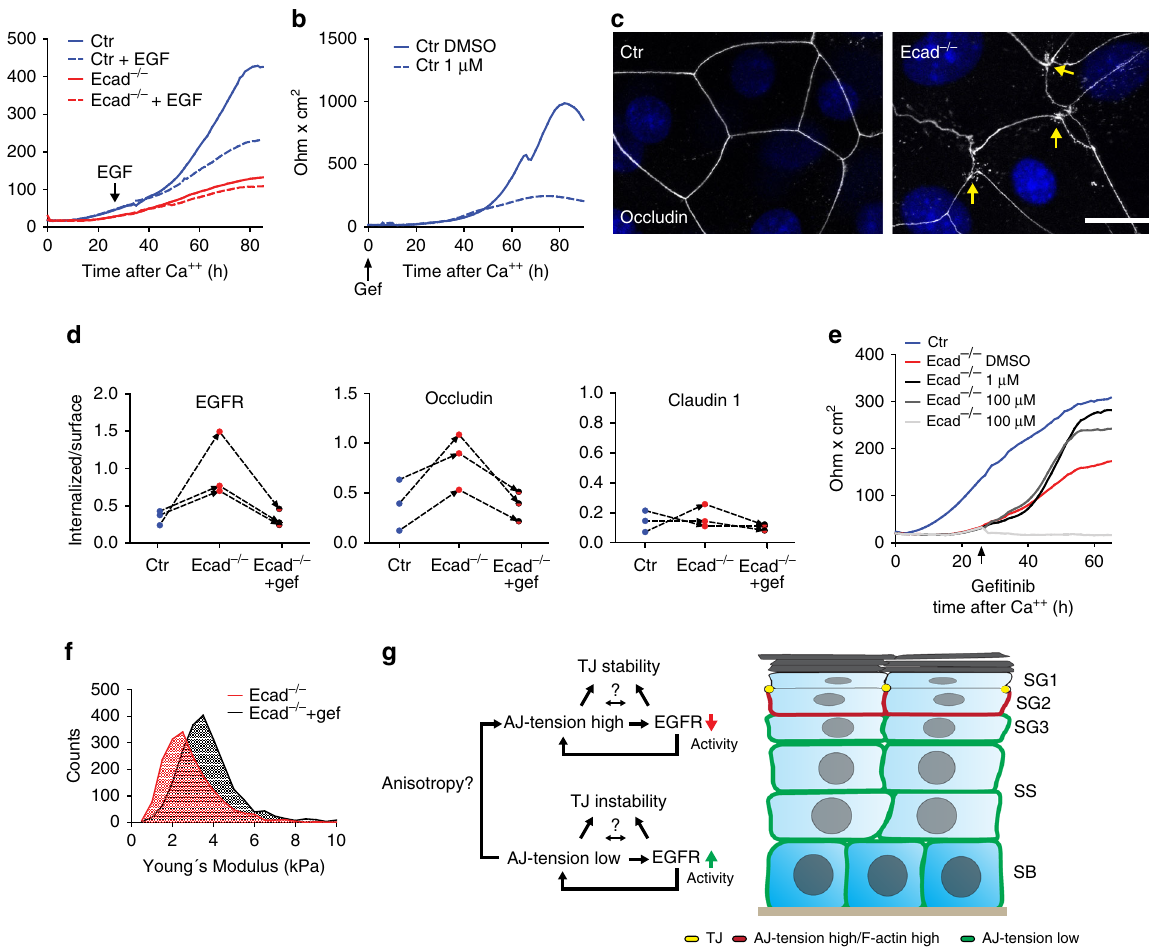
Fig. 8 Spatiotemporal control of EGFR localization and activity controls TJ barrier function. a , b Transepithelial resistance (TER) measurements in primary keratinocytes. a Control (Ctr) keratinocytes were stimulated with EGF (100 ng ml − 1 fi nal concentration) 24 h after switching to high Ca 2+ (dashed line). b Ctr keratinocytes were treated with EGFR inhibitor ge fi tinib starting with switching to high Ca 2+ (0 h). c Immuno fl uorescence analysis of occludin organization in Ctr and E-cadherin (Ecad) − / − primary keratinocytes after 48 h in high Ca 2+ . Scale bar, 20 µ m. Nuclei were stained with DAPI (blue). d Cell surface biotinylation/internalization assay. Graphs represent the relative amount of internalized protein per surface labeled protein 30 min after internalization. Indiviudal experiments are connected by dashed lines. e TER measurement, E-cadherin − / − keratinocytes were treated with different doses of EGFR inhibitor ge fi tinib and EGFR 24 h after switching to high Ca 2+ . Note dose dependent rescue of TER in E-cadherin − / − keratinocytes. a , b , f Representative example of n = 3 biological replicates. f Histogram showing the distribution of Young ’ s moduli obtained from a representative indentation experiment from primary either DMSO or ge fi tinib treated E-cadherin − / − keratinocytes after 48 h in high Ca 2+ (treatment after 24 h) ( n > 500 measurements each treatment). g Model showing how E-cadherin integrates mechanical and chemical signals to restrict the formation of tight junctions to the stratum granulosum